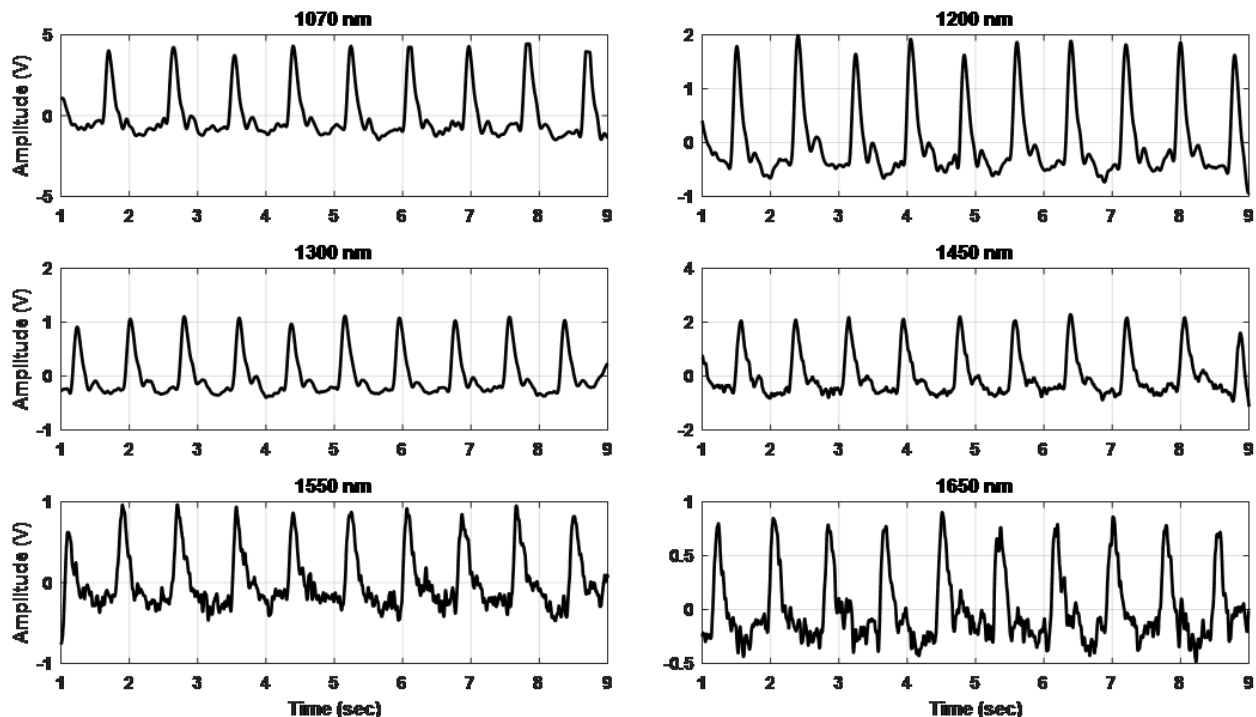
Fig. 10. The ¯ltered PPG signal for six di®erent